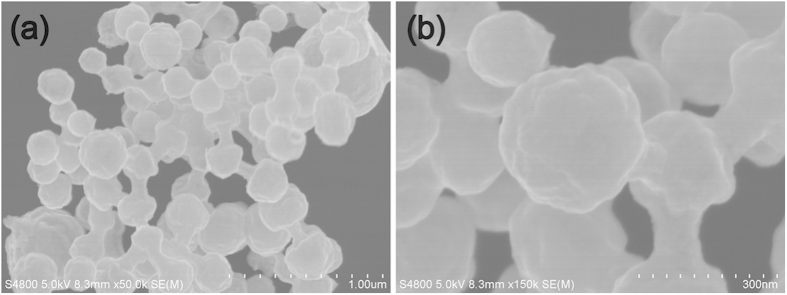
SEM morphology of the CNS/NiCo2O4 core-shell sub-microspheres:(a) low magnification, (b) high magnification.